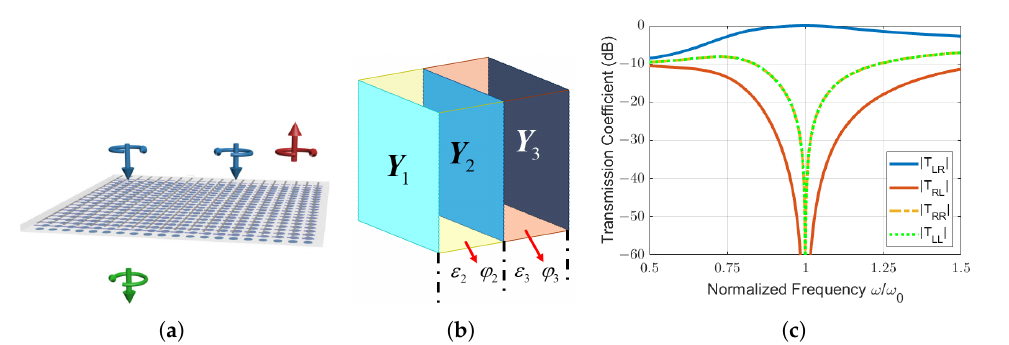
Figure 12. Anasymmetriccircularpolarizer. ( a )Polarization-convertingoperationof themetasurface [23]. ( b ) Unit cell of the asymmetric circular polarizer. ( c ) Simulated transmission